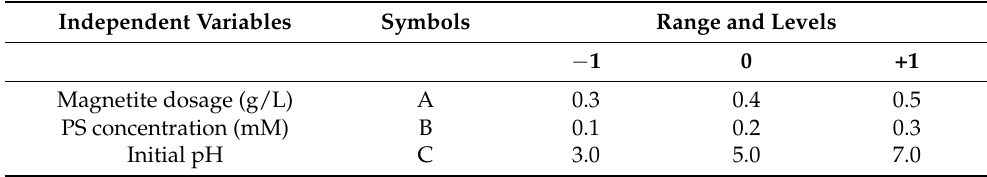
Table 2. Factors and levels of independent variables.